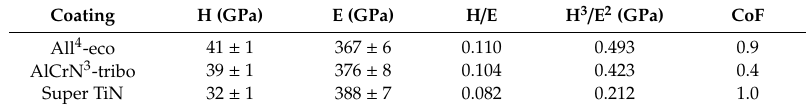
Table 1. Mechanical properties and coefficient of friction (CoF) of the tested PVD coatings.